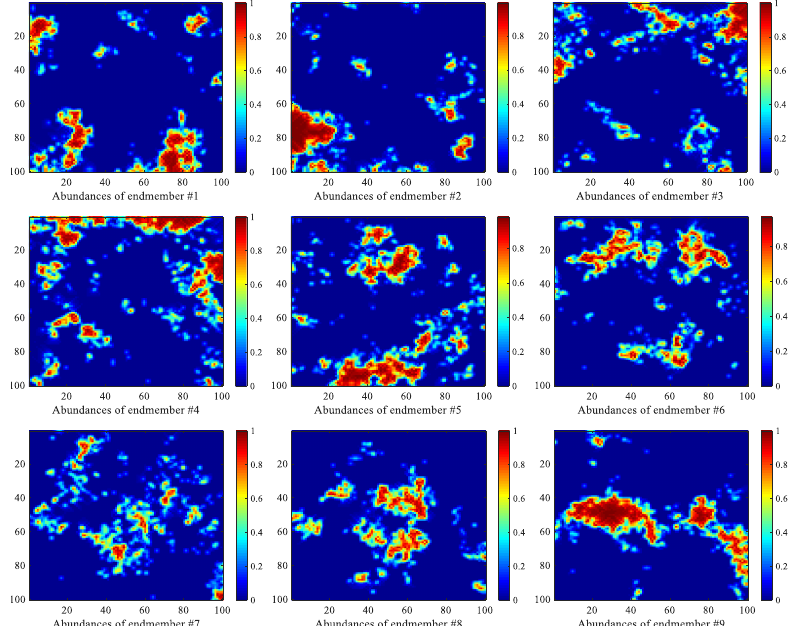
Figure 4. True abundance maps of five endmembers in data 1.